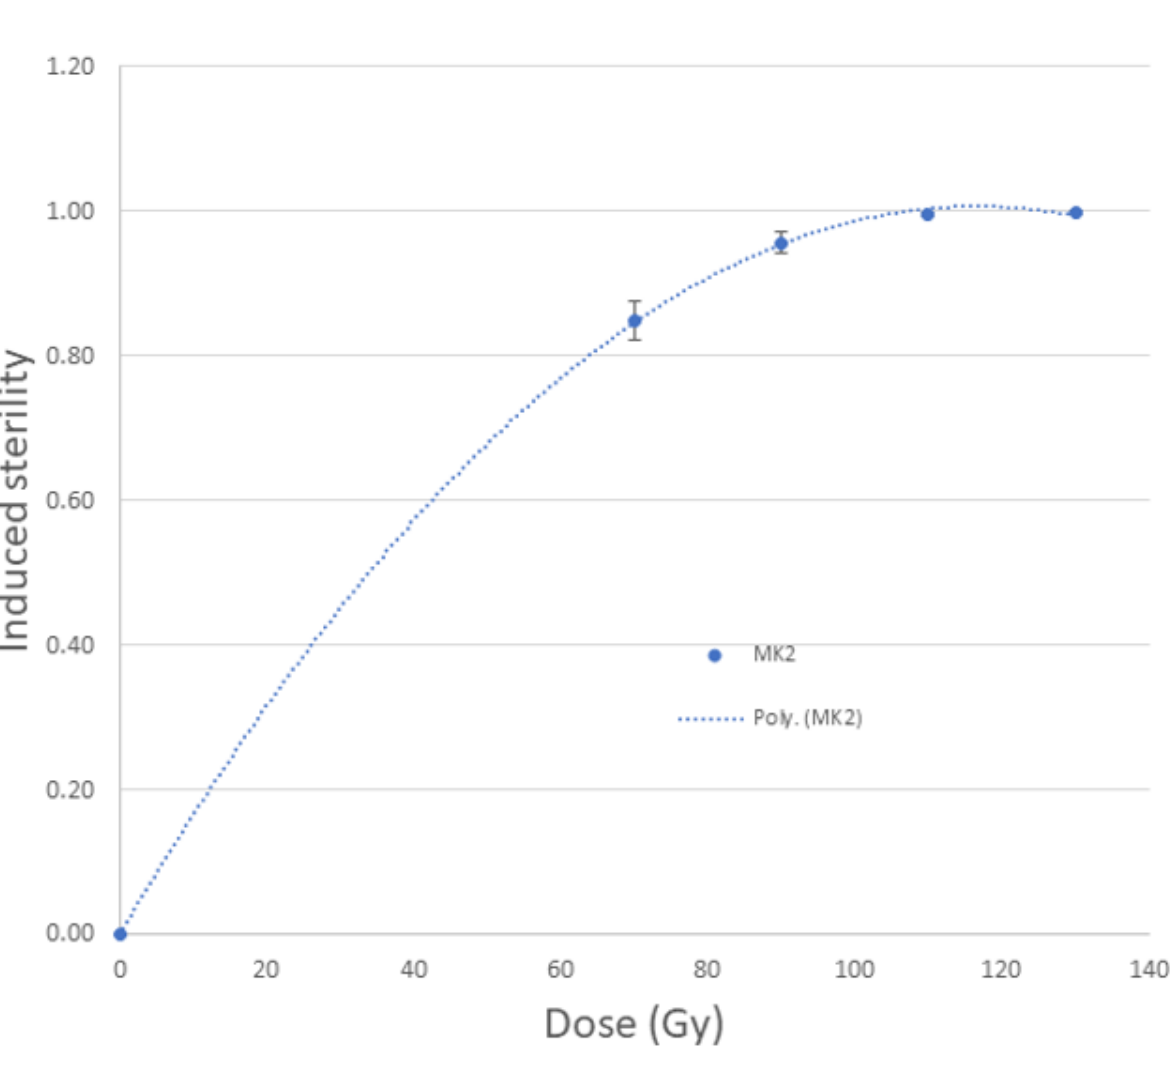
Figure 3. Dose response curve of Glossina palpalis gambiensis pupae irradiated with X-rays in an MK2 irradiator.